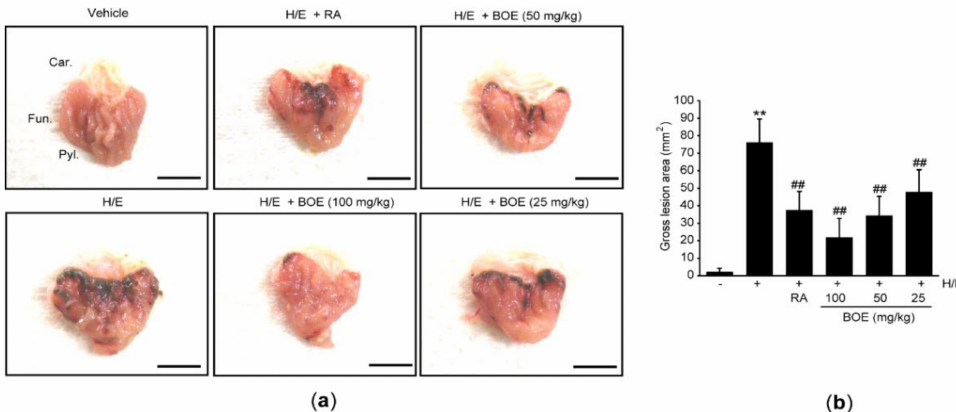
Figure 2. Macroscopic effect of BOE on H/E-mediated gastric damage. ( a ) Representative gross stomach images. Scale bars indicate 6.5 mm. ( b ) Macroscopically visible lesion on the gastric mucosa was quantified as a gross lesion area (mm 2 ). Numerical results are presented as mean ± SD of ten mice (** p < 0.01 between the vehicle and H/E groups; ## p < 0.01 versus H/E-administered group). BOE, B. oleracea var. capitata L. extract; Car., cardiac region of the stomach; Fun., fundus/corpus region of the stomach; H/E, HCl/ethanol; Pyl., pylorus region of the stomach; RA, ranitidine